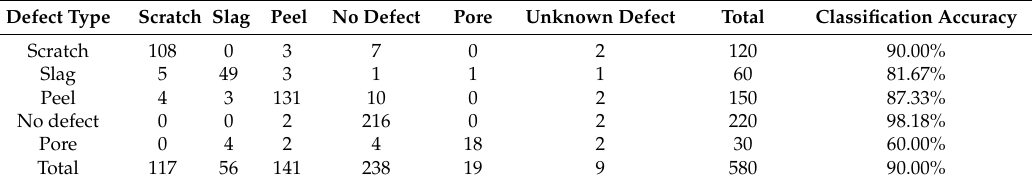
Table 10. New confusion matrix using retrained ELM with new samples of “pore”.